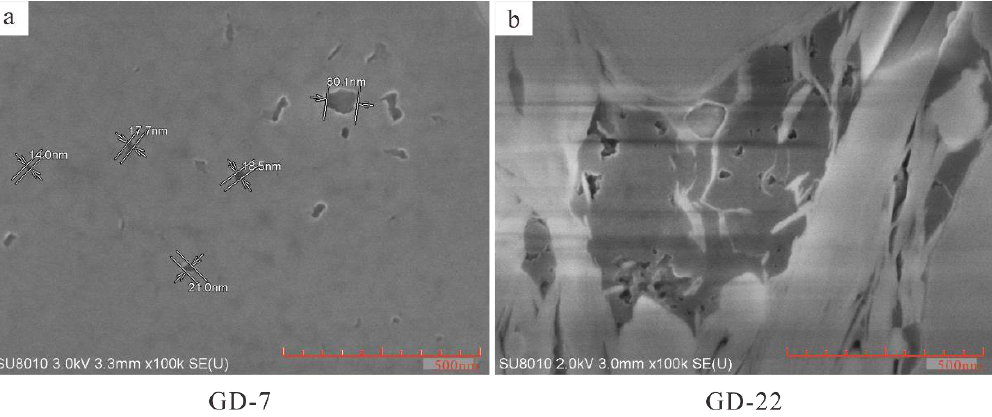
Figure 14. Different kinds of pores in siliceous shale and clay–siliceous mixed shale ( a : organic pore, GD-7; b : intergranular pore, GD-22).